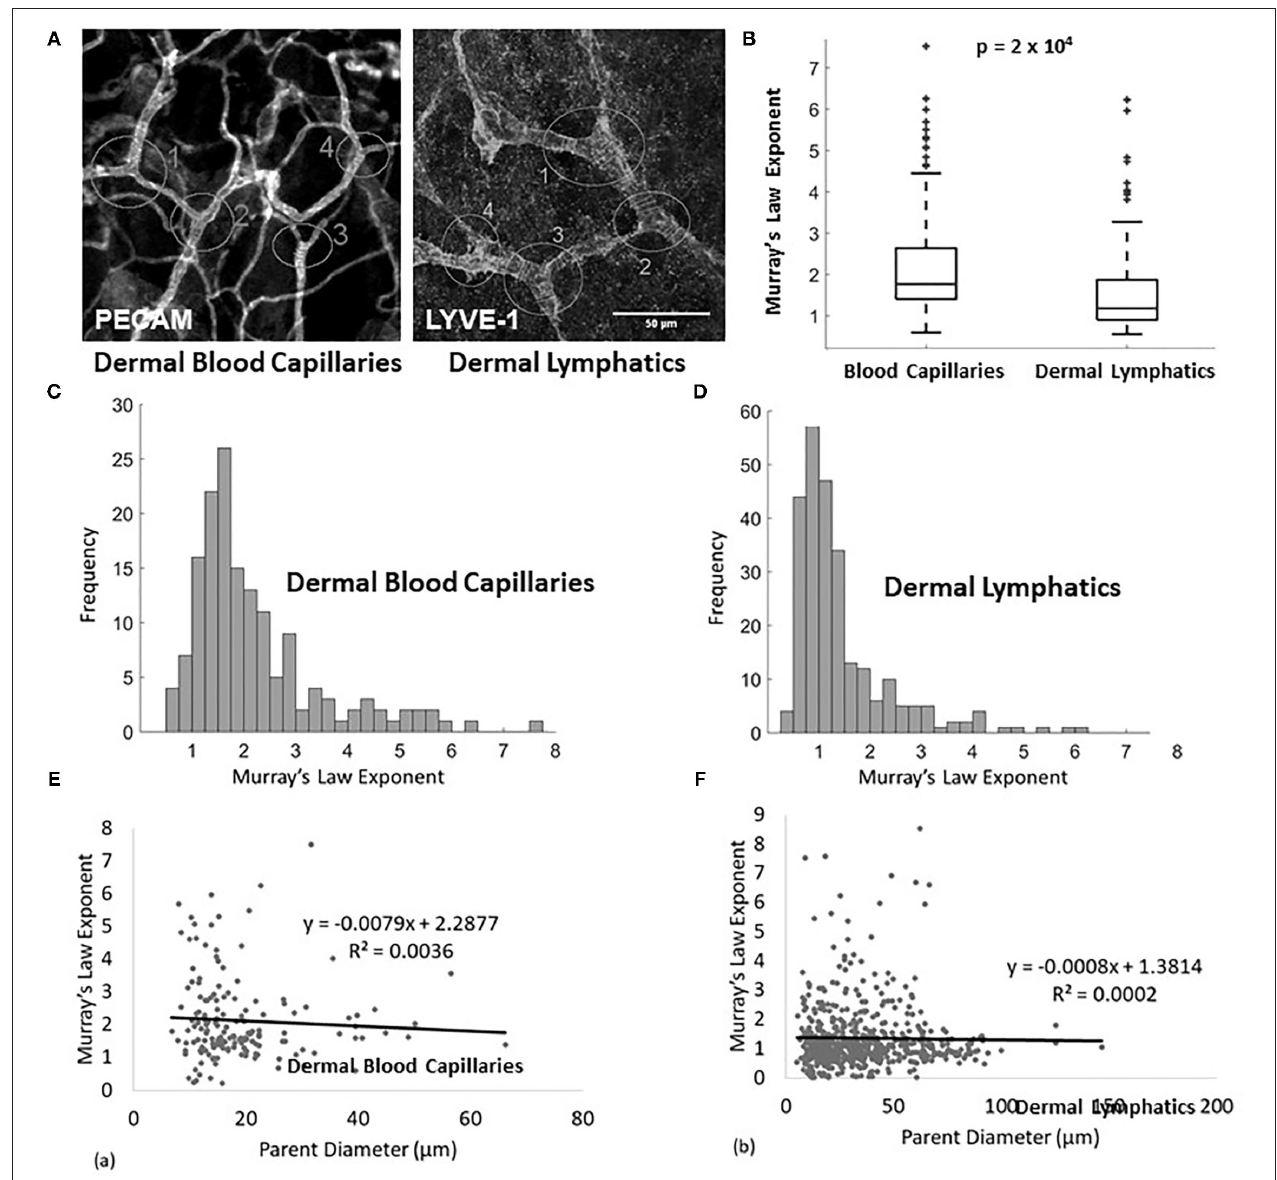
FIGURE 1 | (A) Example of measured lymphatic (LYVE1 stain) and blood capillaries (PECAM stain) of a wild type E14.5 mouse. The analyzed junctions are identified with white circles and measured diameters are marked with white lines. (B) Murray’s Law exponent for blood capillaries ( n = 155 measurements, n = 8 mice) and lymphatic capillaries ( n = 93 measurements, n = 8 mice) in wild type adult mice. (C) Murray’s Law exponent distribution for blood capillaries. The right skew is a result of variability in a sample with a mean close to and bounded by 0. (D) Murray’s Law exponent distribution for dermal lymphatic capillaries in wild type mice. The right skew is a result of variability in a sample with a mean close to and bounded by 0. (E,F) The calculated Murray’s Law exponents do not correlate with parent vessel size at the scale of the measured capillaries for (E) blood or (F) dermal lymphatics. The exponent distributions are not skewed due to size effects.